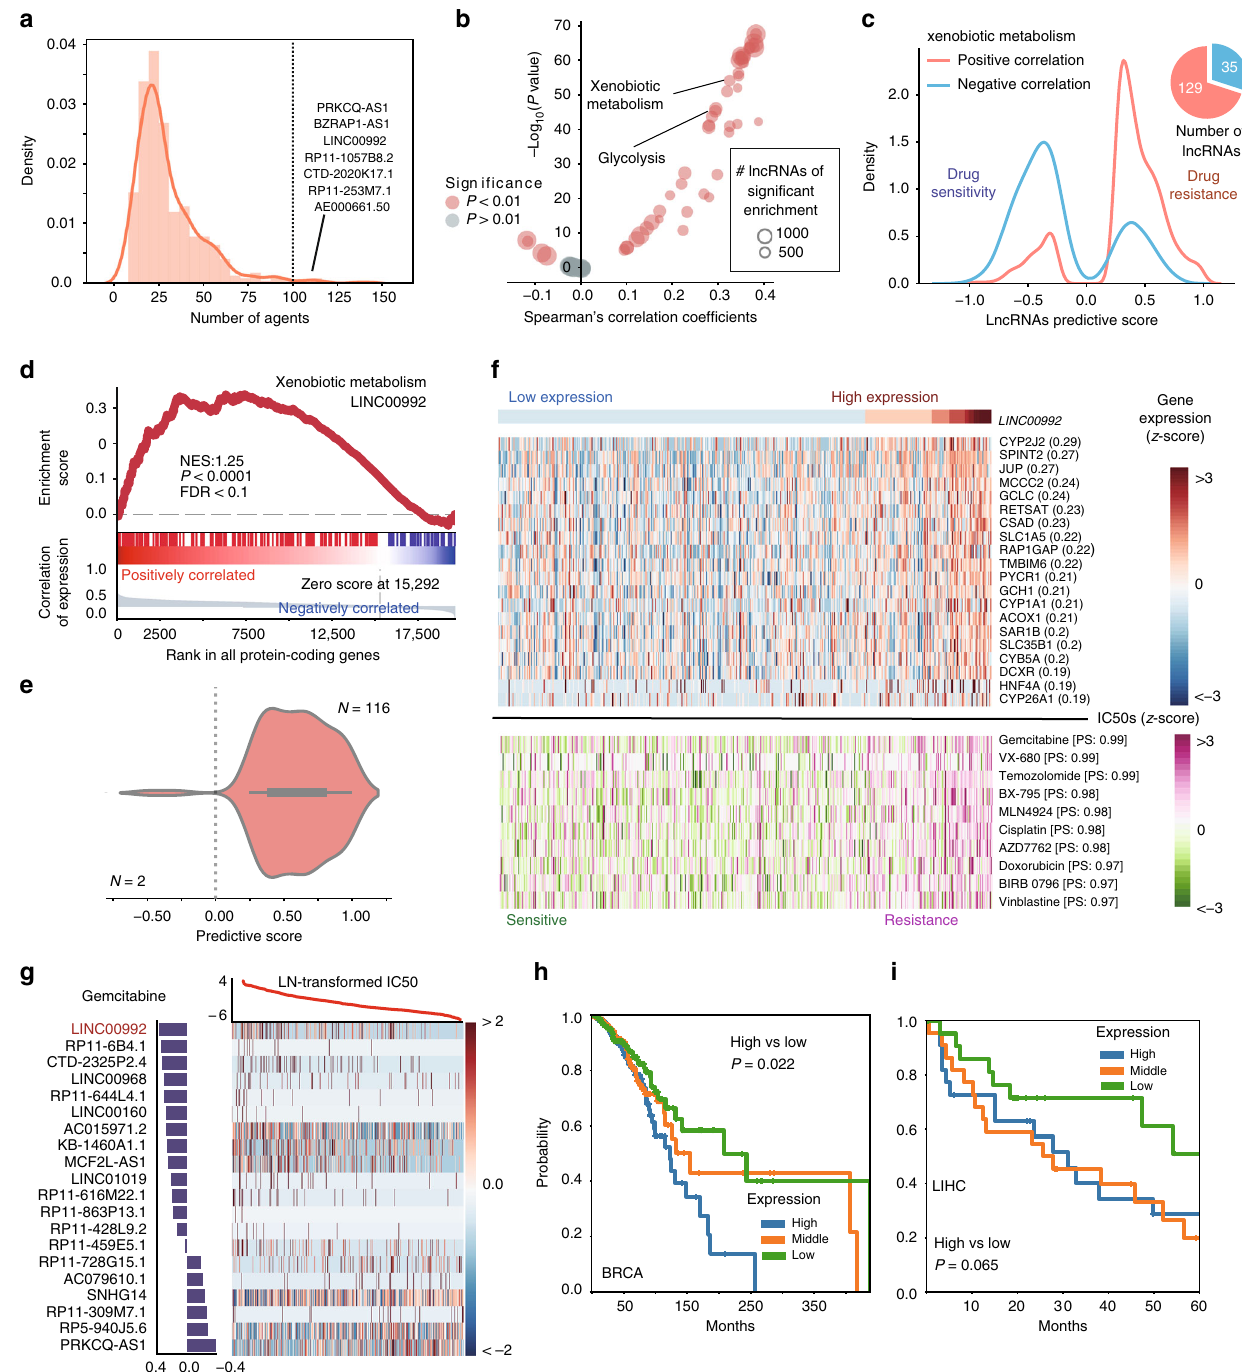
Fig. 5 Co-expressed pathways reveal that LncRNAs induce multi-drug resistance by regulating xenobiotic metabolism pathway. a Distribution of the number of agents that multi-agent response (MDR) related lncRNAs are predictive to. The listed are the top fi ve lncRNAs predicting the greatest number of agents ’ response in cell lines. b Correlation between the Shannon entropy of lncRNAs and their absolute normalized enrichment score across cancer hallmarks pathways. c Marginal distribution of predictive score in pan-cancer models. The red (blue) color denotes MDR-related lncRNAs that are positively (negatively) associate with xenobiotic metabolism genes. The pie chart on the right indicates the ratio between two groups of lncRNAs. d GSEA analysis of association between LINC00992 and xenobiotic metabolism genes. e Distribution of LINC00992 ’ s predictive score across the agents. f The association among the high expression of LINC00992 , genes in xenobiotic metabolism and the IC50s of top predictable agents across cancer cell lines. The upper heatmap shows the expression level from blue (low) to red (high) colors. The lower heatmap shows the IC50s from green (sensitive) to purple (resistant) colors. g Pan-cancer LENP model for gemcitabine. The top curve shows observed IC50 of gemcitabine in each cell line. The central heatmap shows the top predictive lncRNA expression in the model across all cell lines ( x -axis). Bar plot (left): weight of the top predictive lncRNAs in the model for gemcitabine sensitivity (bottom) or insensitivity (top). h , i The Kaplan – Meier curves of overall survival for patients grouped into three groups of equal sample size, i.e., high, median, low, by LINC00992 expression level in BRCA and